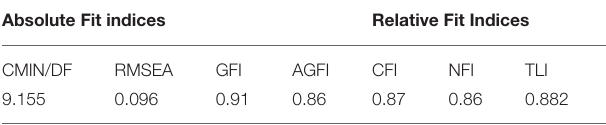
TABLE 2 | The goodness of fit statistics for